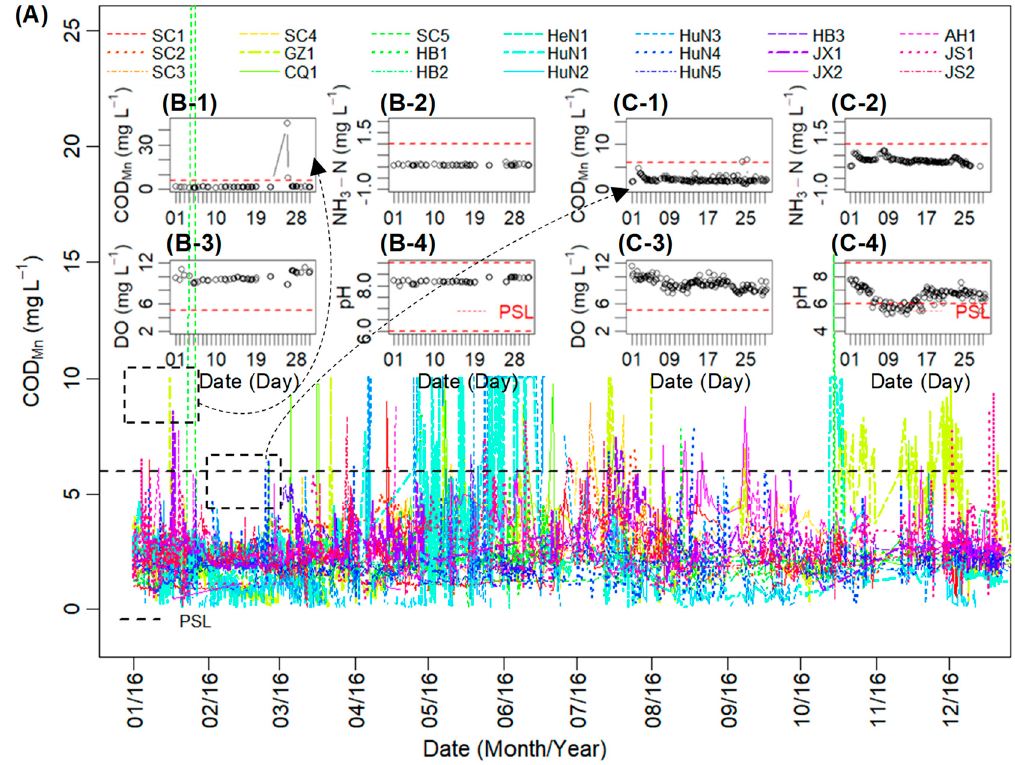
Figure 10. Real-time series for COD Mn ( A ) at the 21 YRB sites in 2016 and real-time series for Site SC5 in January 2016 ( B1–4 ) and Site HuN4 in February 2016 ( C1–4 ).